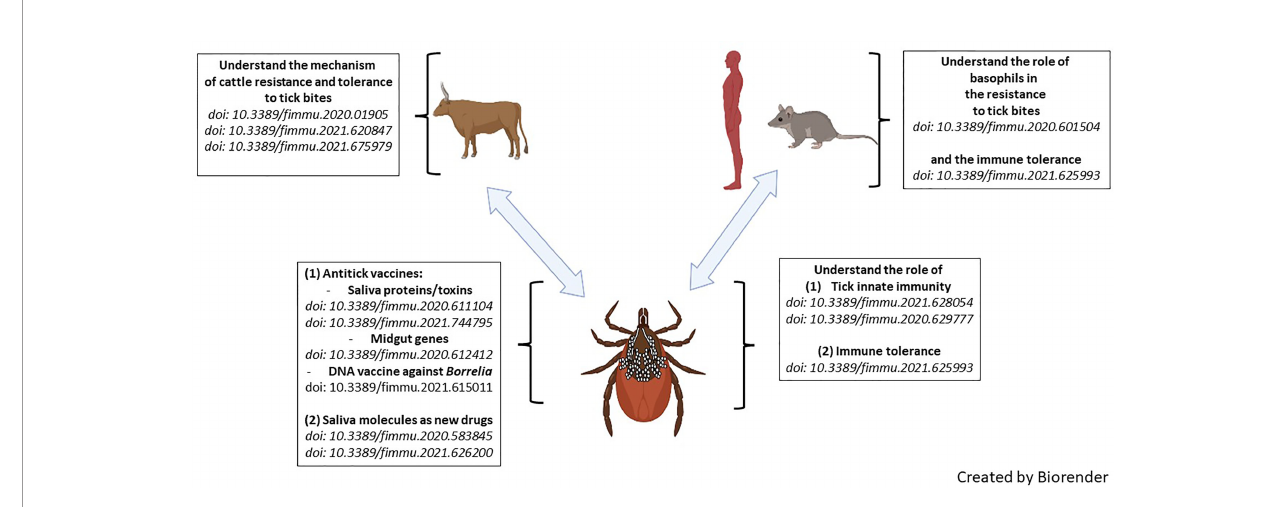
FIGURE 1 | GraphicalabstractofarticlespublishedinthisResearchTopicentitled ‘ TicksandHostImmunity – NewStrategies forControllingTicksandTick-BornePathogens ’